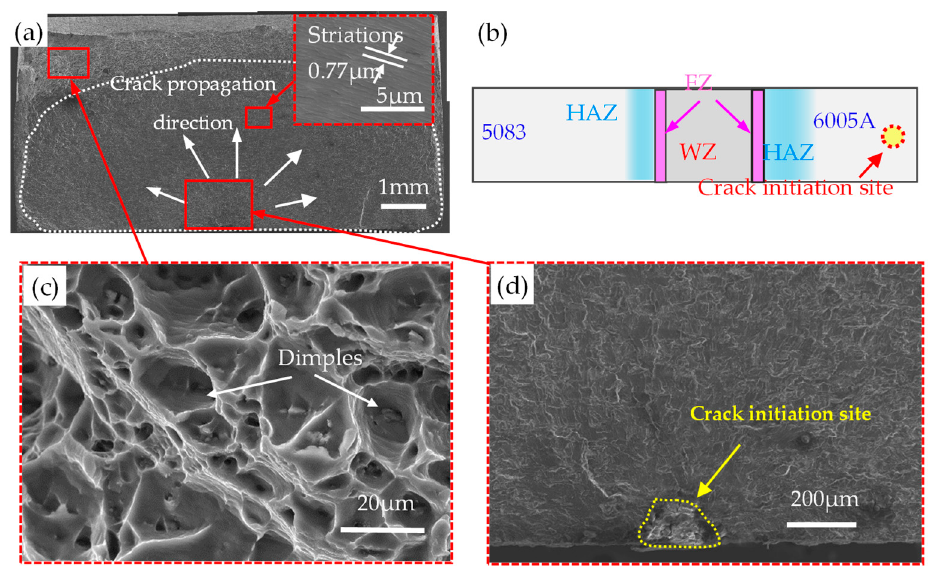
Figure 6. SEM images of fatigue fracture of the 5083/6005A welded joints corroded for three days: ( a ) overall fracture diagram; ( b ) schematic diagram of fracture location; ( c ) dimples; ( d ) crack source.